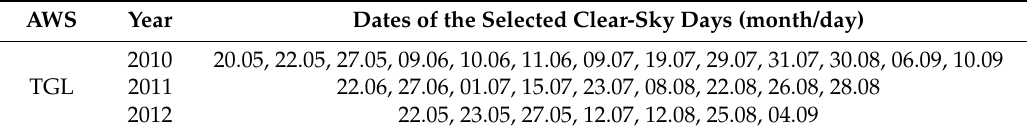
Table A3. The measured data used to fit and verify the parameterized scheme under clear-sky conditions at each site in the permafrost region.